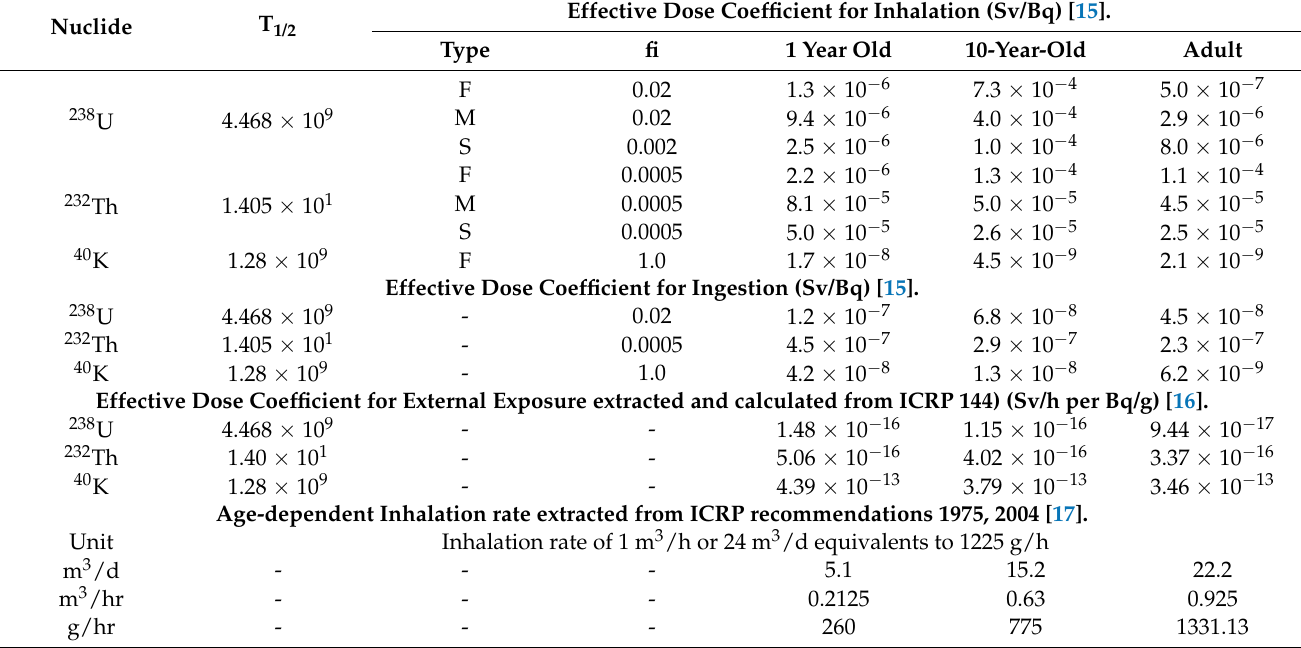
Table 2. Age-dependent dose coefficients and inhalation